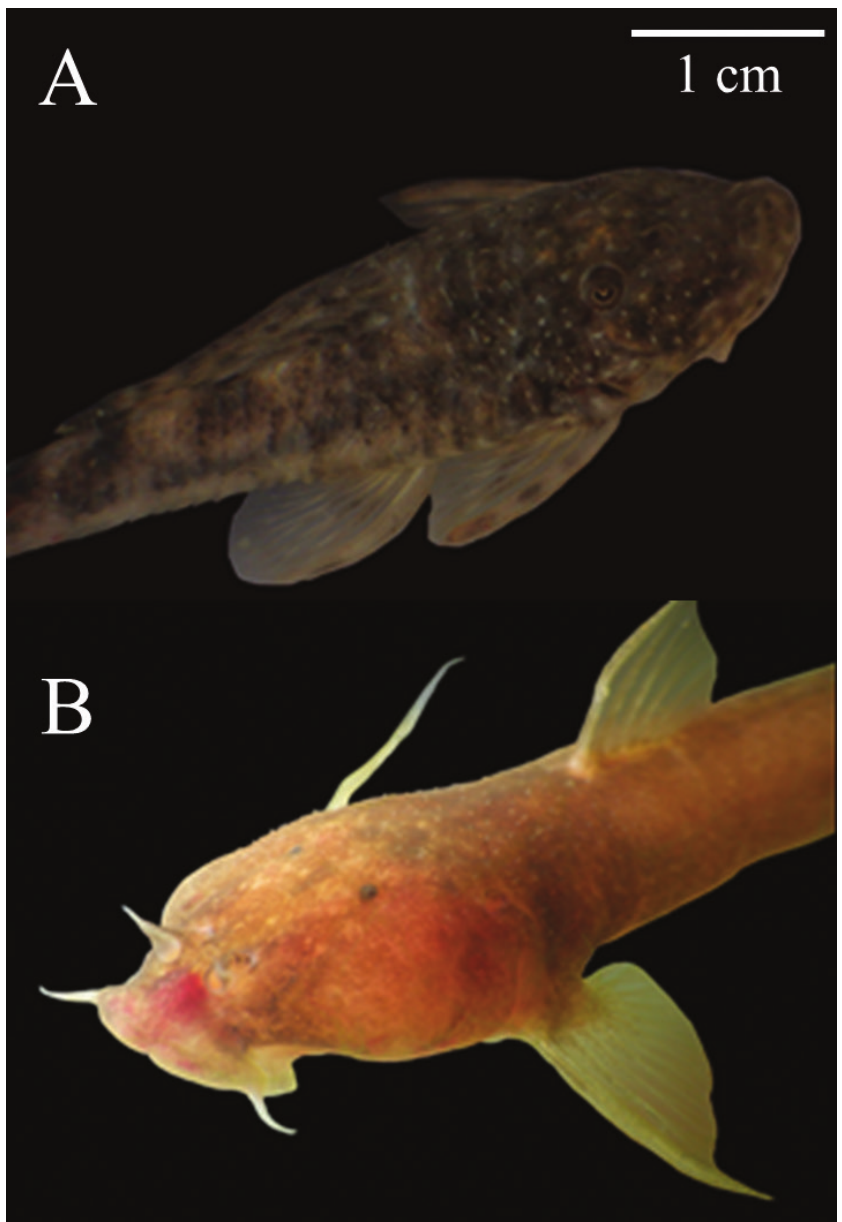
Figure 3. A Chaetostoma microps (Surface catfish) B Astroblepus pholeter (Cave catfish). Both species inhabit the same river